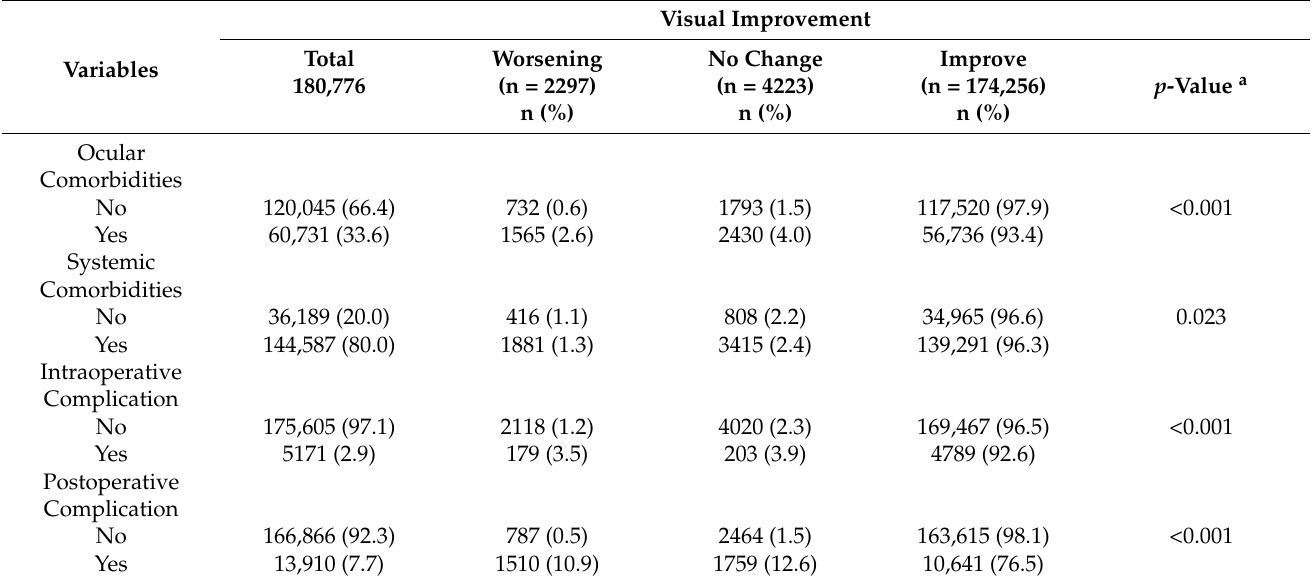
Table 3. Comorbidities and complication factors according to the level of improved visual acuity.